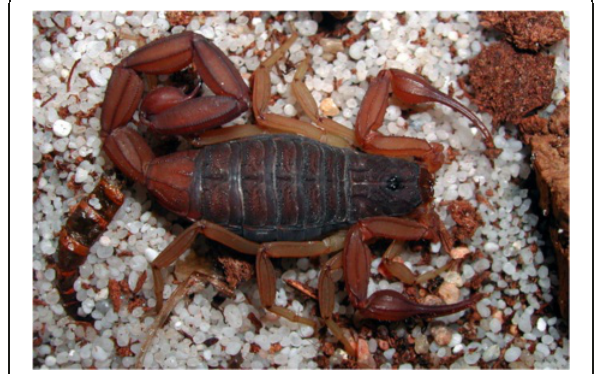
Fig. 15 Centruroides ochraceus (Pocock, 1898); female from